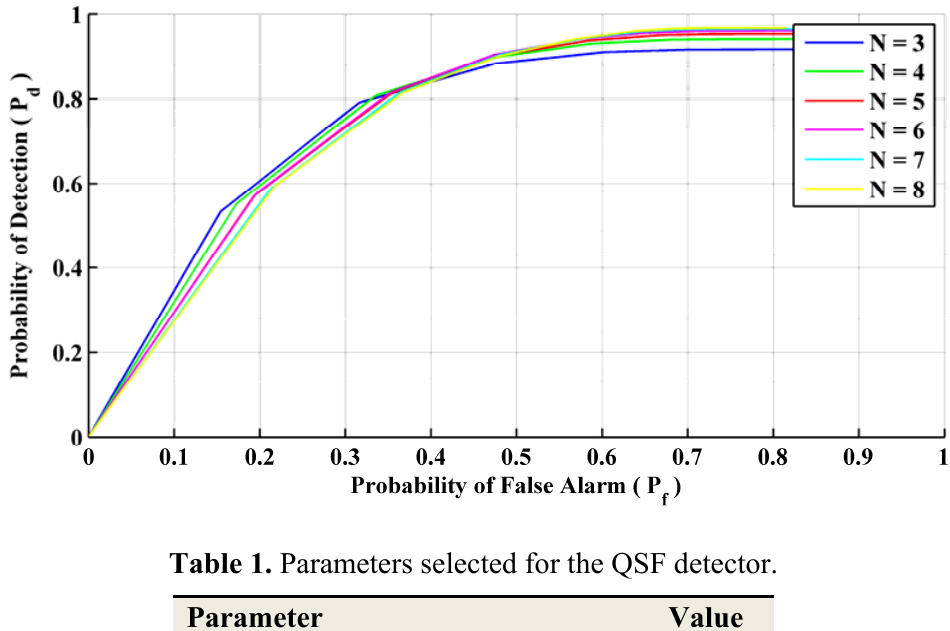
Figure 5. ROC for different window sizes.